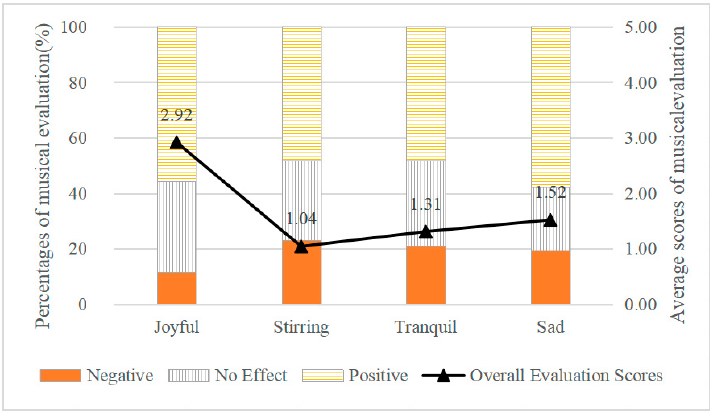
Figure 5. The E ff ect of Musical Emotions on Musical Evaluation during Figure 5. The Effect of Musical Emotions on Musical Evaluation during Communication.